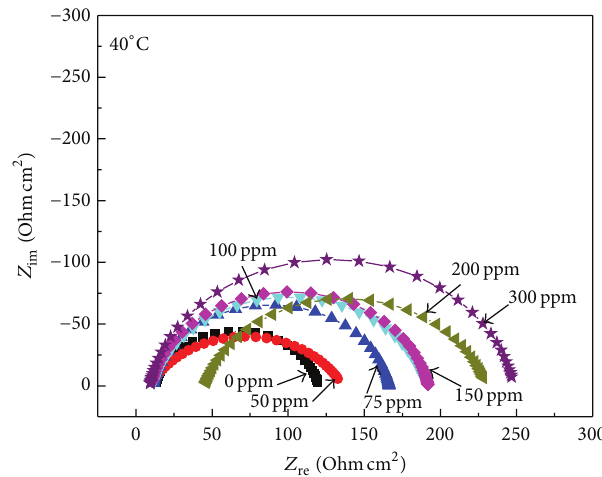
Figure 6: Effect of Opuntia ficus-indica concentration on the Nyquist diagrams for carbon steel in 1M HCl at 25 ∘ C.